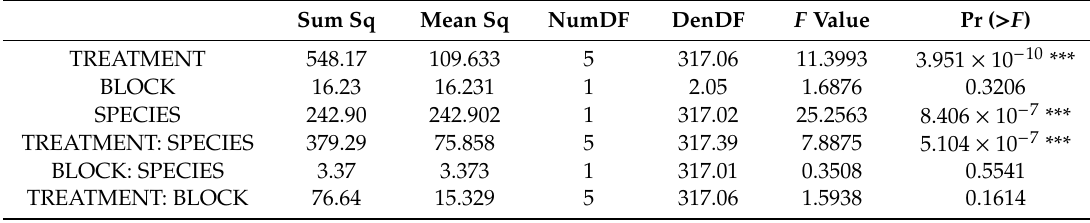
Table A2. Type III Analysis of Variance Table with Satterthwaite’s method.